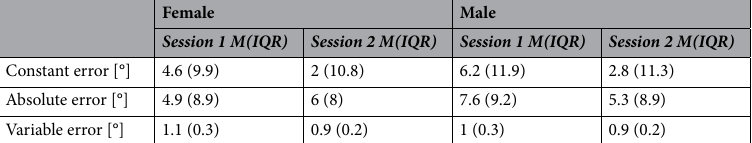
Table 2. Constant, absolute and variable angular error displayed per sex and session. M median; IQR interquartile